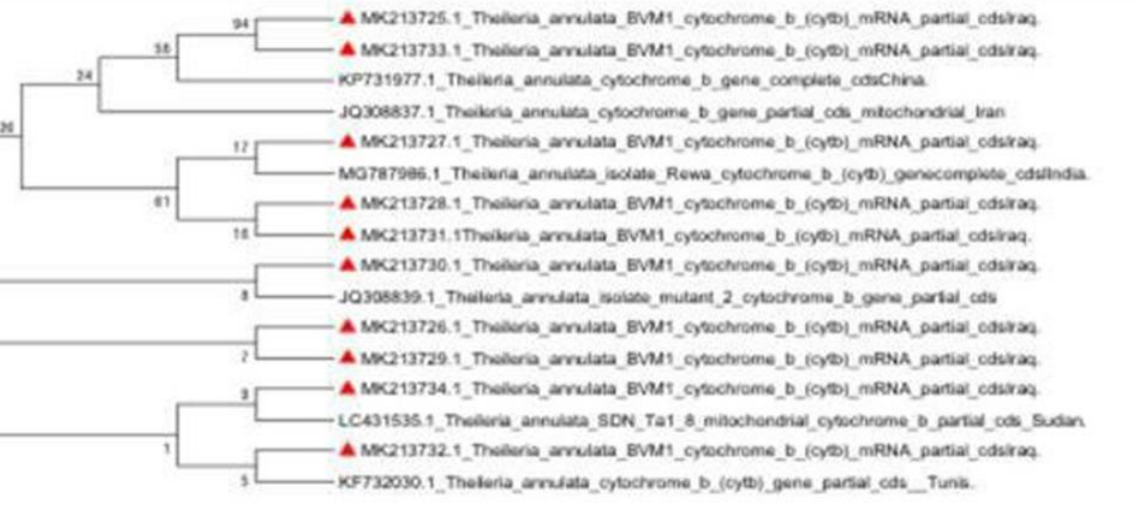
Figure, 6: Analysis of phylogenetic tree based on the partial sequence small subunit of cytochrom b ofTheileria annulata, local and global sequences using neighbor joining bootstrab 1000 radiation tree figure evolutionary